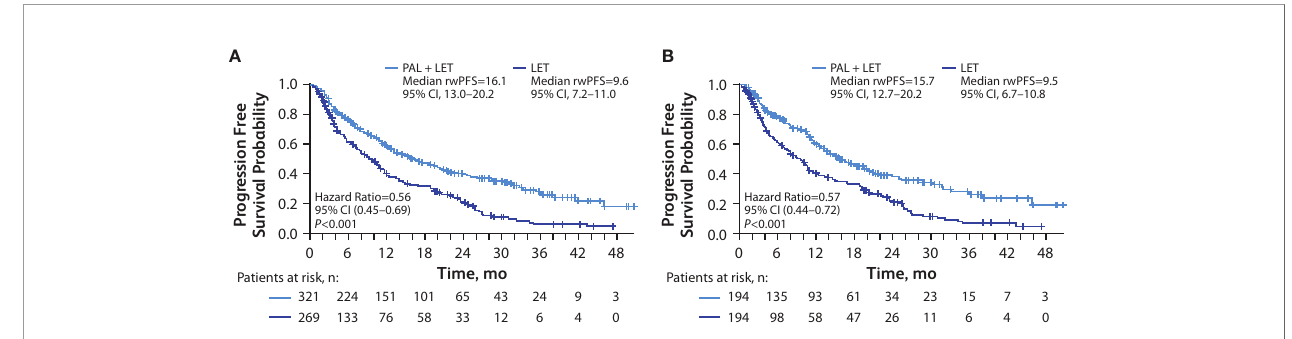
FIGURE 1 | Kaplan-Meier curves of real-world progression-free survival in patients with visceral (lung and/or liver) metastasis. sIPTW analysis (A) and PSM analysis (B) ; number of patients at risk are shown. LET, letrozole; PAL, palbociclib; PSM, propensity score matching; rwPFS, real-world progression-free survival; sIPTW, stabilized inverse probability treatment